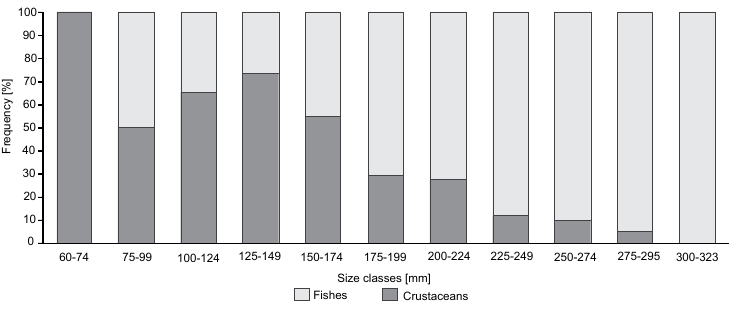
Fig. 2. Variations in two major prey groups (fi shes and crustaceans) consumed by red lionfi sh, Pterois volitans , in eleven length